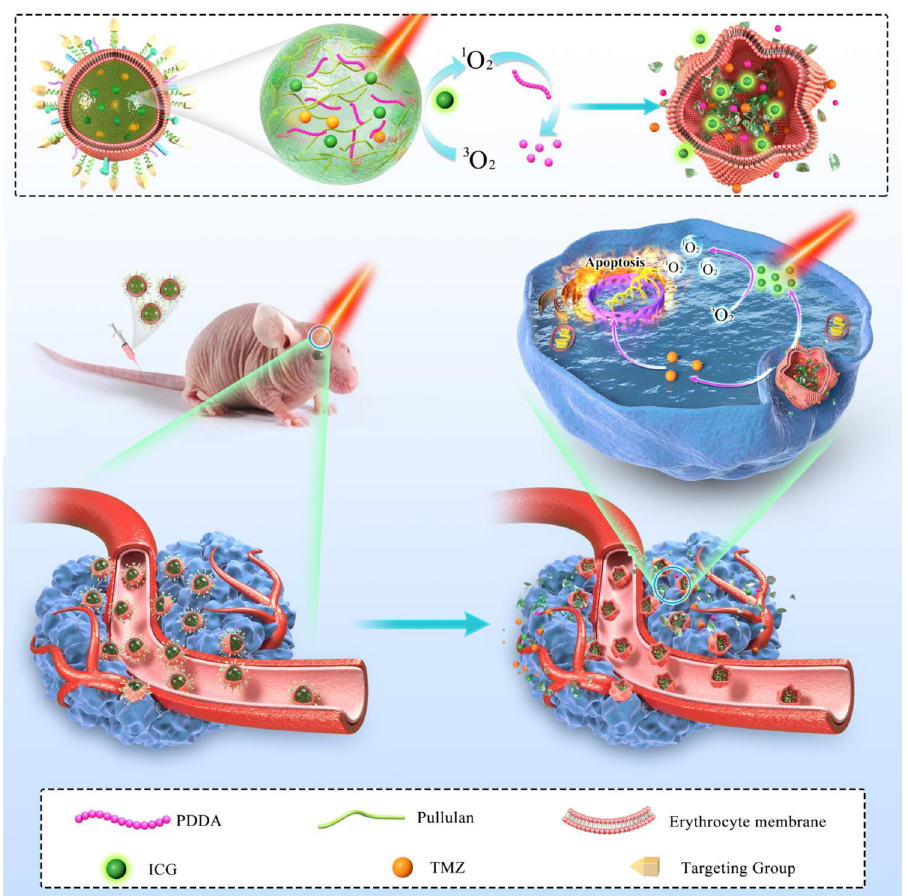
Fig.1|Schematicillustrationofnearinfrared-activatablebiomimeticnanogels for orthotopic GBM therapy. ApoE-modi fi ed erythrocyte membranes were cloaked on the surface of nearinfrared-activatablebiomimetic nanogels co-loaded with photosensitizers ICG and TMZ. These biomimetic nanogels accumulate